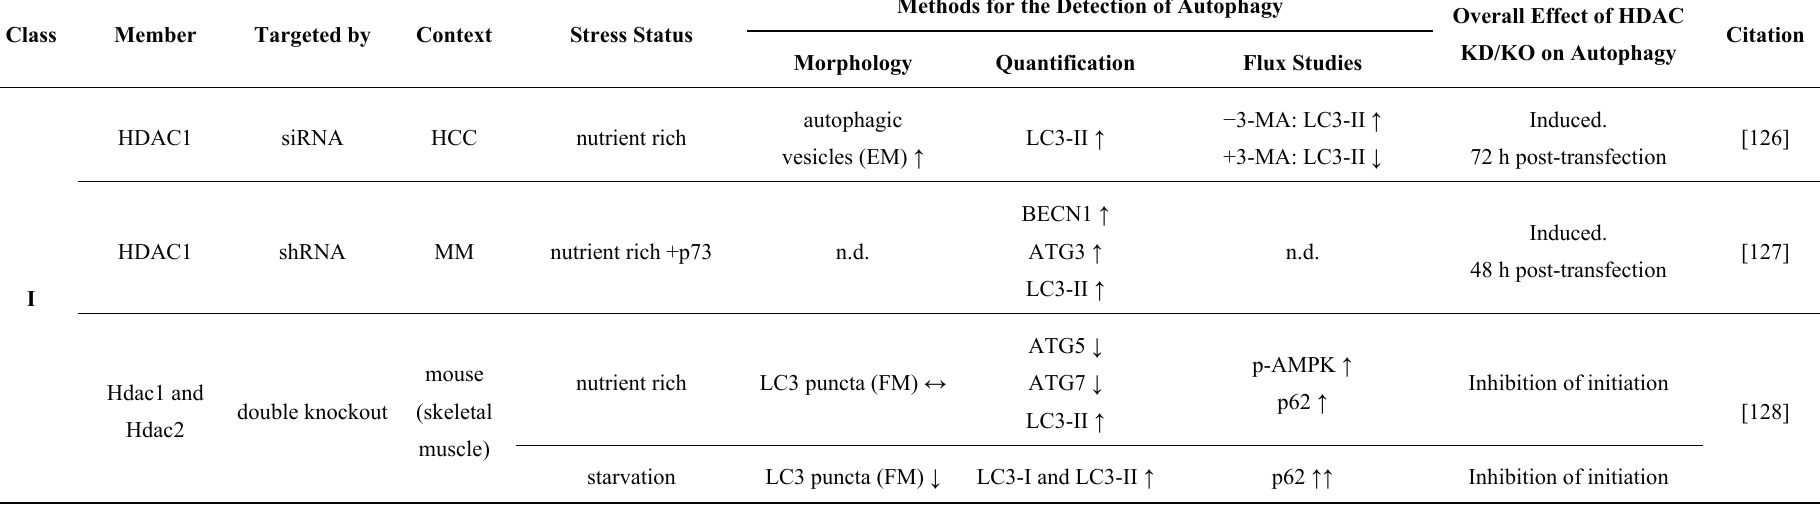
Table 2. Summary of classical HDAC family members and their effect on autophagy. KD—knock-down;